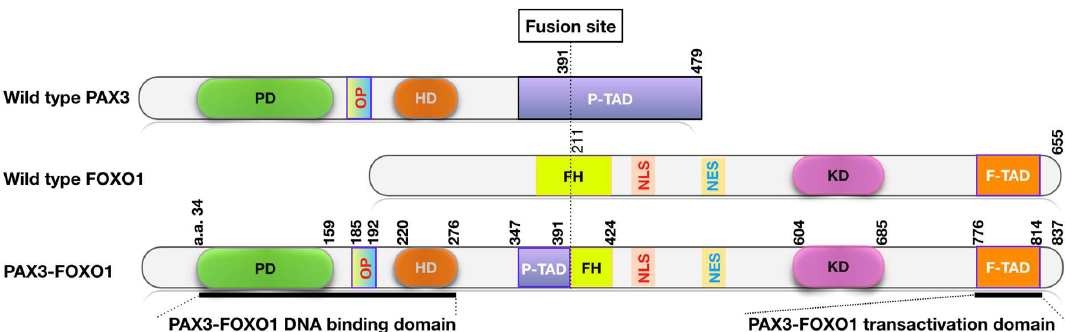
Figure 1. Protein domain structures of the wild-type PAX3, FOXO1 and PAX3-FOXO1 fusion proteins. The numbers indicate the corresponding amino acids present on each protein. Abbreviations: PD, Paired box domain; OP, octapeptide motif; HD, homeobox domain; P-TAD, PAX3